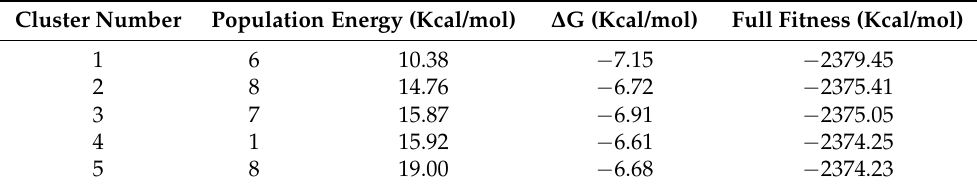
Table 2. Data obtained by molecular docking protocols with the SwissDock server.